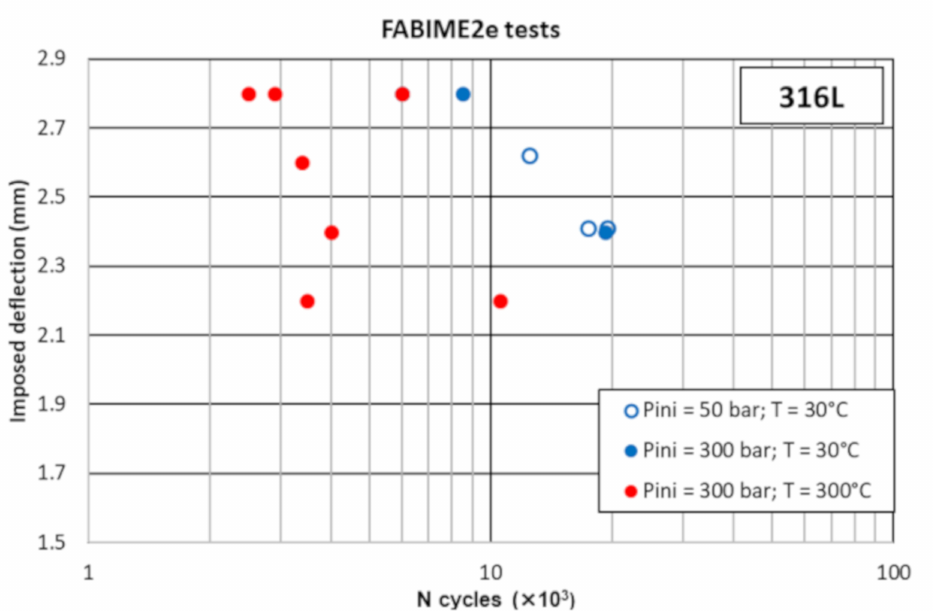
Figure 14. Experimental data of spherical fatigue tests obtained with the FABIME2e device for different conditions (temperature,